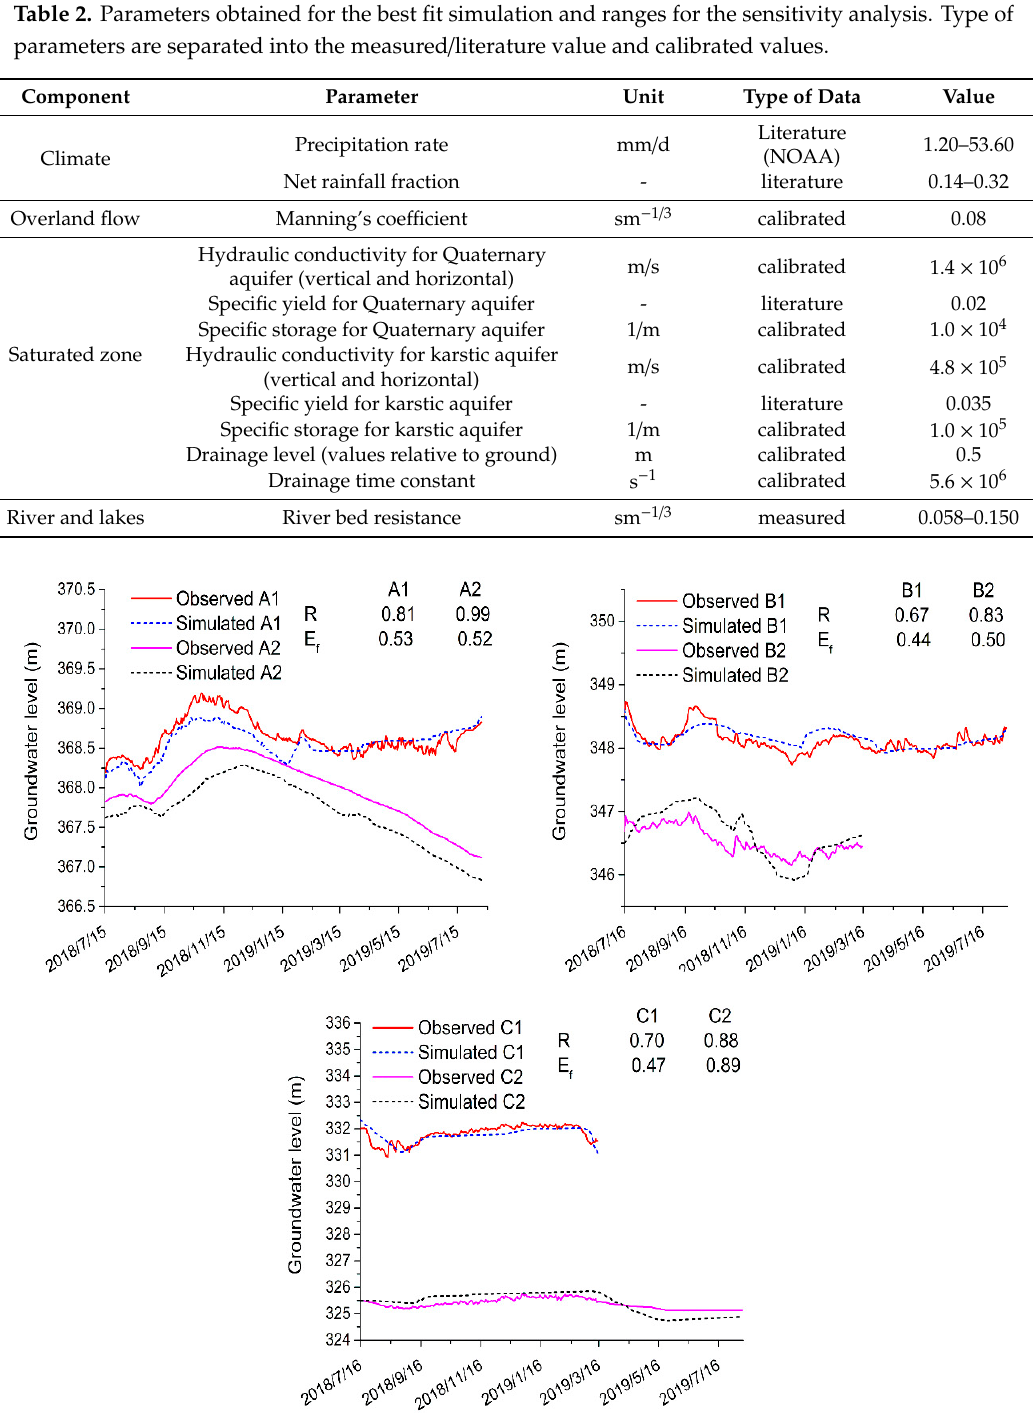
Figure 7. Comparison of the simulated with the observed groundwater levels . 4.3. Connectivity between the river and the wetland groundwater.